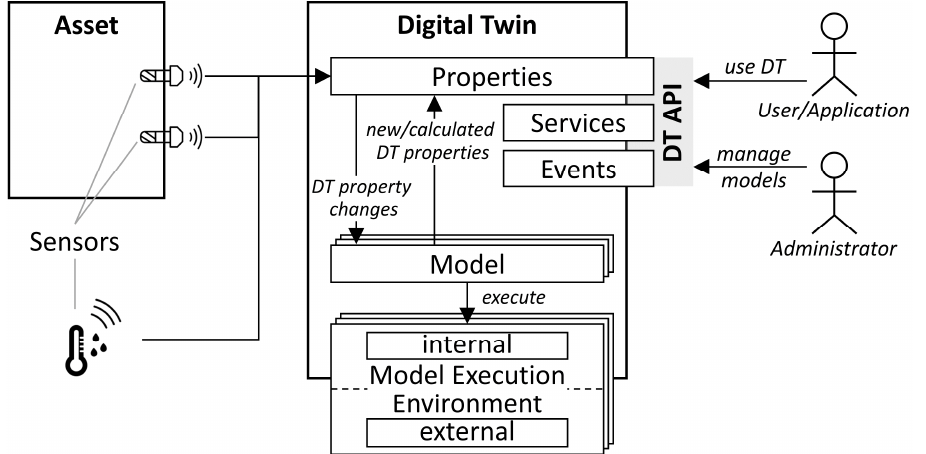
Figure 2. General architecture for realizing hybrid digital twins.